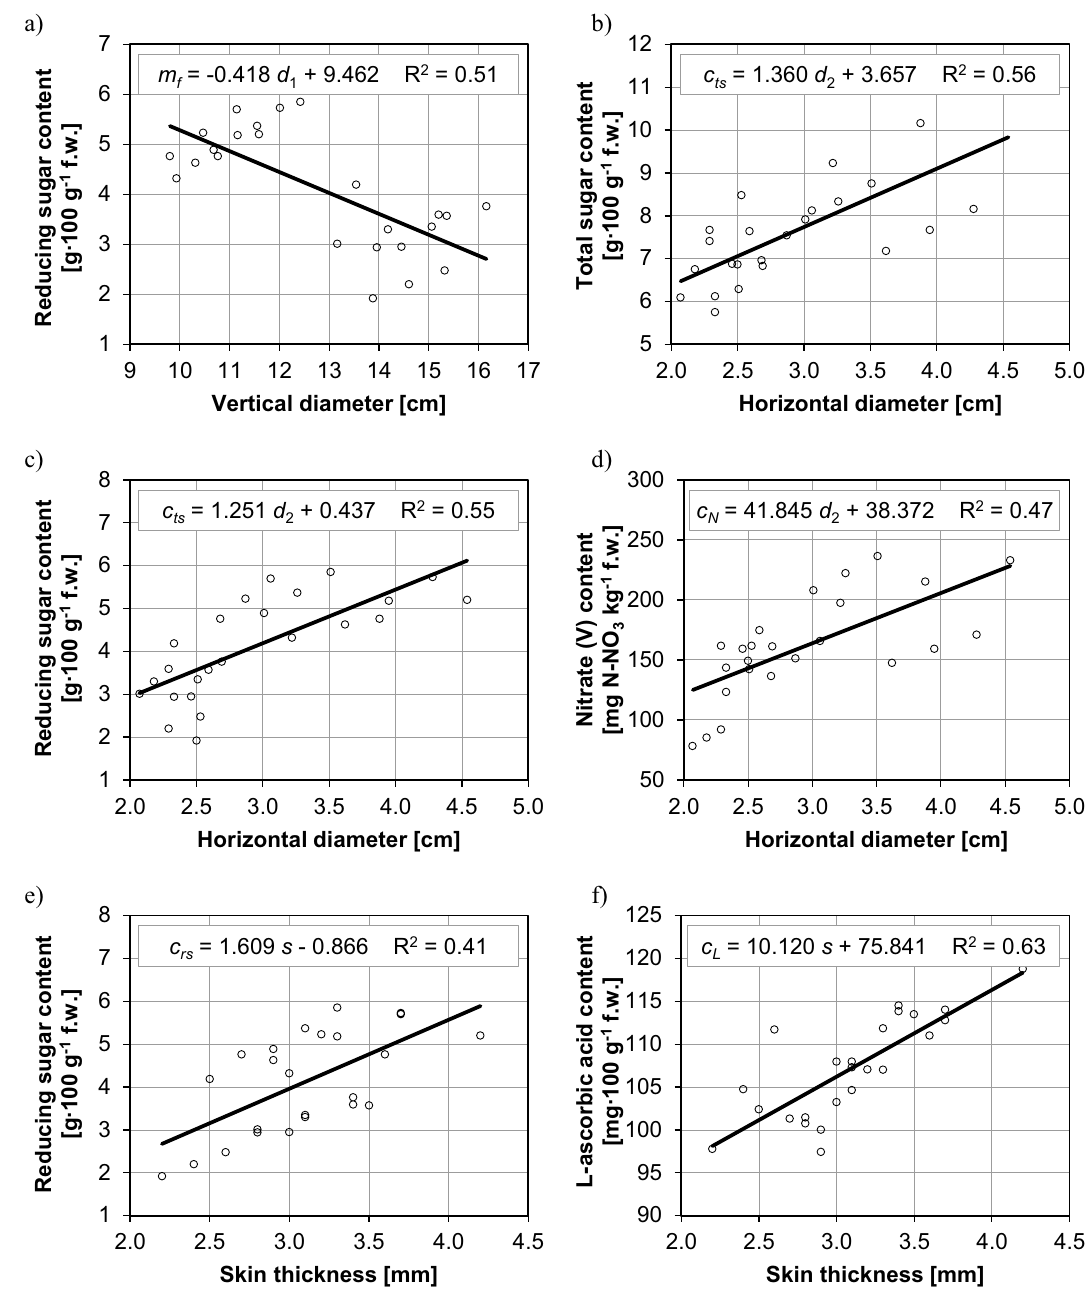
Figure 3. Relationships between the biometric parameters and chemical composition of fruit in hot cultivars of Capsicum annuum : ( a ) vertical diameter and reducing sugar content, ( b ) horizontal diameter and total sugar content, ( c ) horizontal diameter and reducing sugar content, ( d ) horizontal diameter and nitrate (V) content, ( e ) skin thickness and reducing sugar content, ( f ) skin thickness and L-ascorbic acid